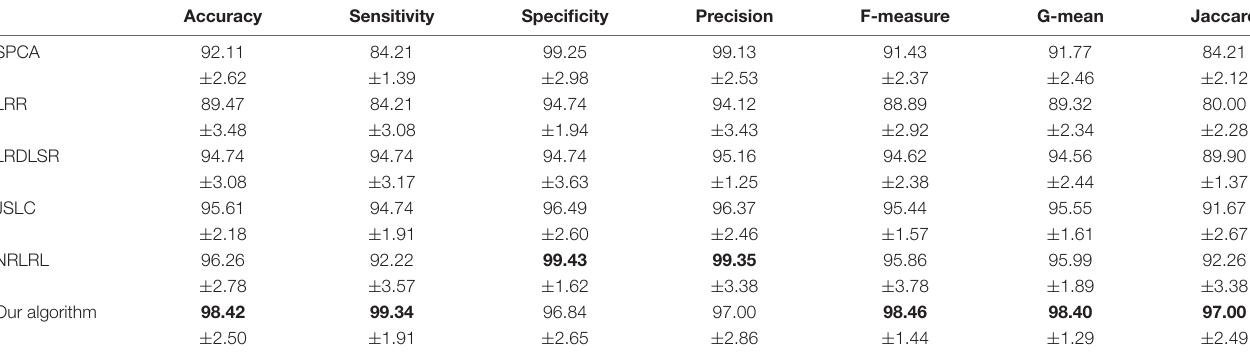
TABLE 3 | Classification results of the comparison algorithms in HC and (MCI+AD) dataset.